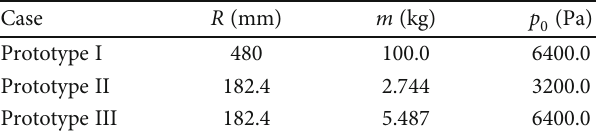
Figure 2: FE model of in fl atable cushion system.